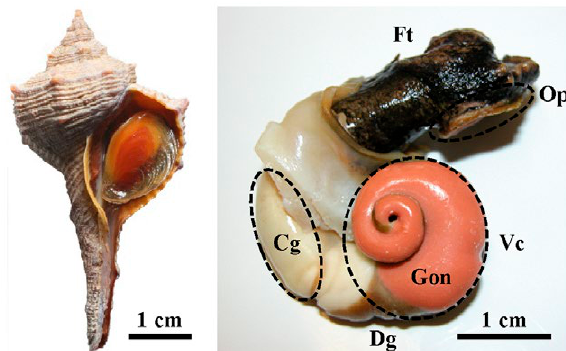
Fig. 2. – Purple dye murex ( Bolinus brandaris ): live specimen and soft parts of the organism (edible content) after shell breakage. Ab- breviations: Cg, Capsule gland; Dg, Digestive gland; Ft, foot; Gon, gonad; Op, operculum; Vc, visceral coil (digestive gland and gonad